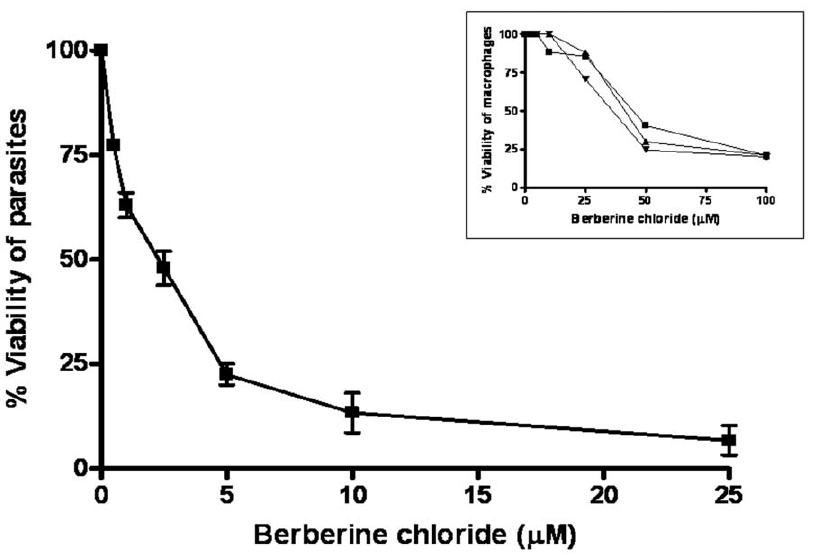
Figure 1. Anti amastigote activity and safety index of Berberine chloride. The anti-leishmanial activity of Berberine chloride (0–25 m M, 72 h) was tested in intracellular amastigotes as described in Methods. Each point corresponds to the mean 6 SD of at least three experiments in duplicate. Inset : The effect of Berberine chloride (0–100 m M) on viability of murine macrophages was evaluated at 48 h ( & ), 72 h ( m ) and 96 h ( . ) by the MTS- PMS assay as described in Methods. Each point corresponds to the mean 6 SD of at least three experiments in duplicate.